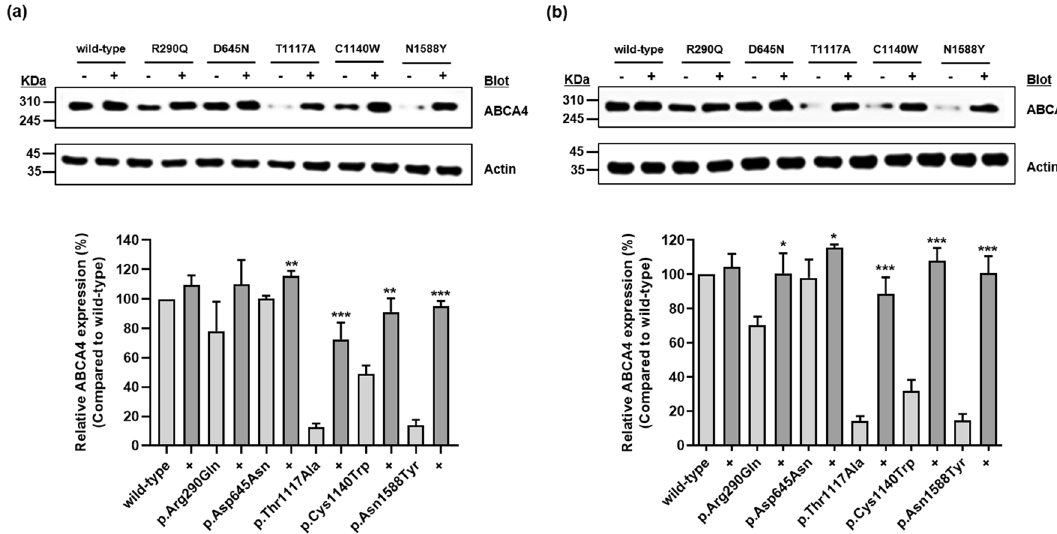
Figure 2. Effect of MG132 or bafilomycin A 1 on ABCA4 expression. ABCA4 expression was examined after transfection with ABCA4 wild-type or variant plasmids. Immunoblotting was performed after treatment with MG132 (a) or bafilomycin A 1 (b) . Images were cropped, and full-length blots were presented in Supplementary Fig. 2. Data represent the mean ± SD from three independent experiments analyzed using Student’s t test.